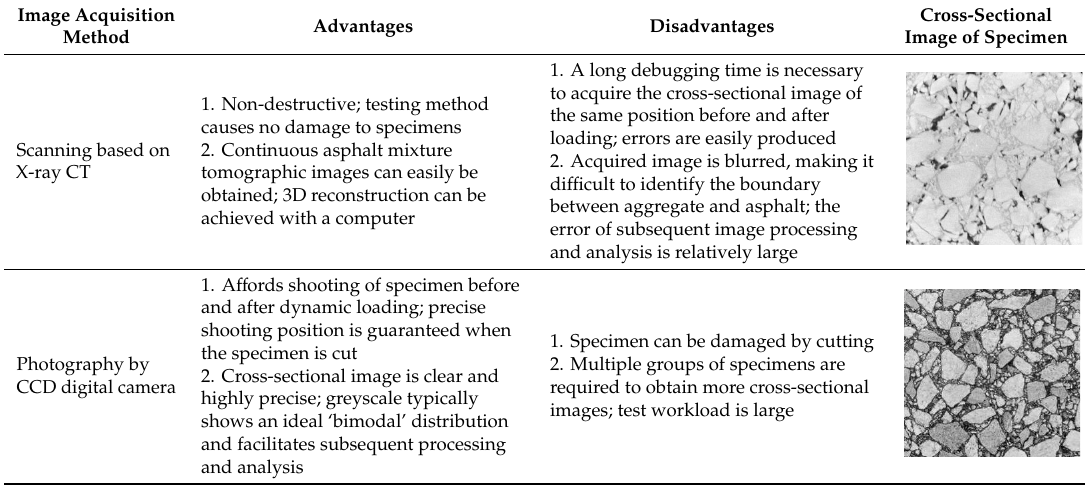
Table 1. Advantages and disadvantages of two image acquisition methods.